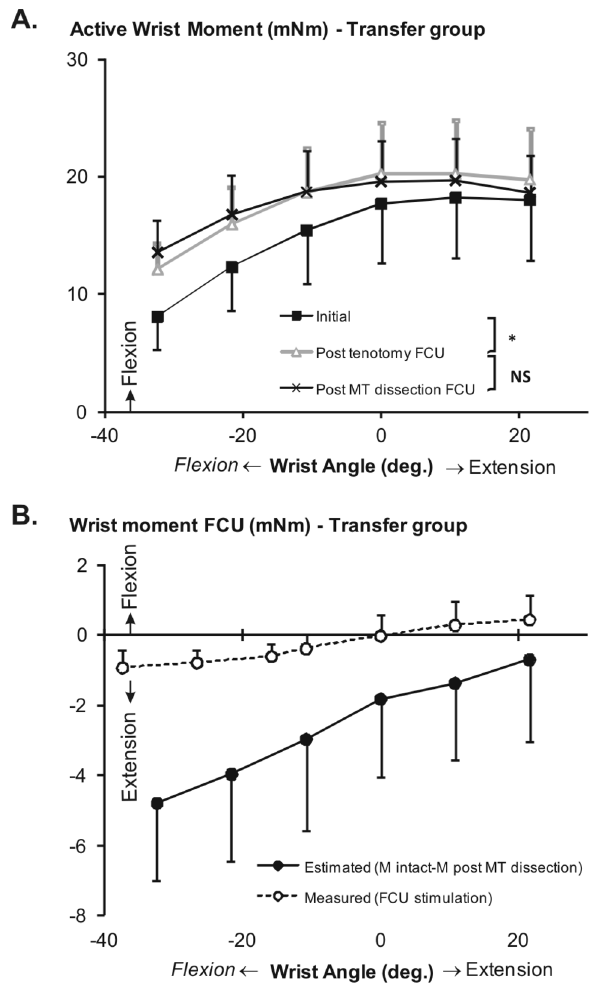
Figure 3. Tendon transfer group wrist angle-moment characteristics. A. Active wrist moment exerted by the remaining wrist flexors and FCU on stimulation of ulnar and median nerves as a function of wrist angle. Asterisk denotes significant differences (p < 0.05) between successive conditions related to state of dissection. NS, not significant. Values are shown as mean + or - SD (n = 6). B. The estimated moment of FCU muscle, as calculated by subtracting wrist moments exerted after both FCU tenotomy and MT dissection from moments measured in the initial condition. Positive values correspond to flexion moments and negative values to extension moments. The dashed line indicates the wrist angle-moment characteristics of selectively activated transferred FCU in five of the same rats (previously reported [26]). The two curves were significantly different (ANOVA). doi: